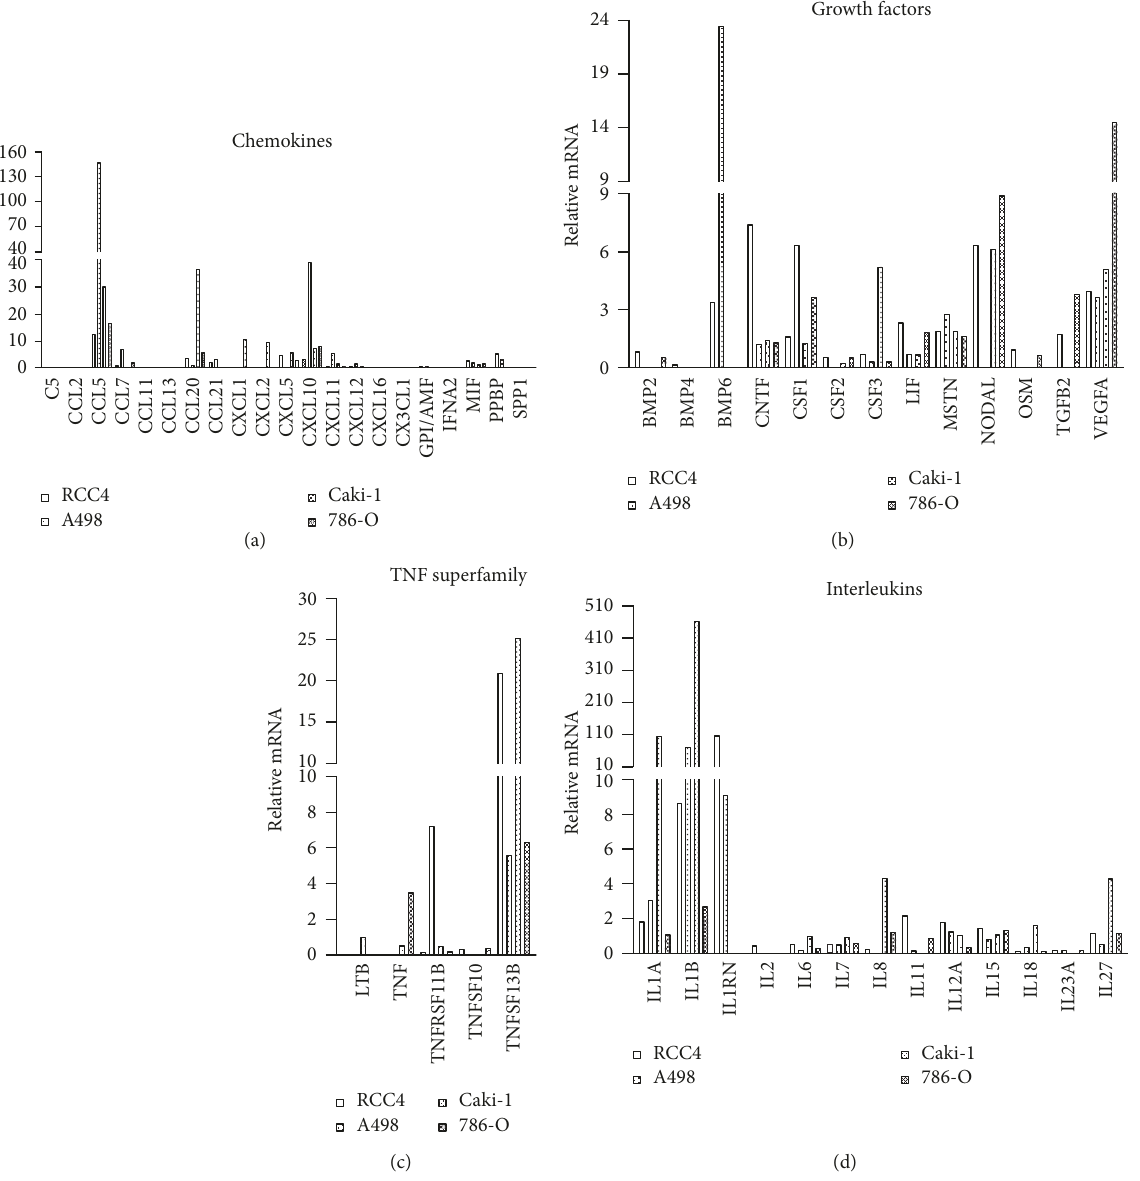
Figure 4: Expression pro fi le of cytokines and chemokines in RCC cell lines. Expression data of cytokines and chemokines in the RCC cell lines Caki-1, 786-O, RCC4, and A498 as well as in the nonmalignant renal cell line RC-124 were measured performing a DNA array (Human Cytokines & Chemokines RT 2 Pro fi ler PCR Array; Qiagen) and expressed as relative mRNA normalized to nonmalignant RC- 124 cells (RC-124=1.0). Cytokines and chemokines were classi fi ed into the four groups of chemokines (a), growth factors (b), TNF superfamily members (c), and interleukins